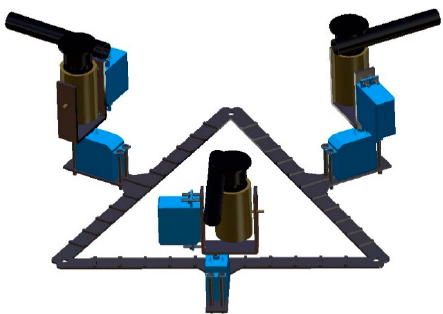
Figure 3. Propulsion system of SURII .